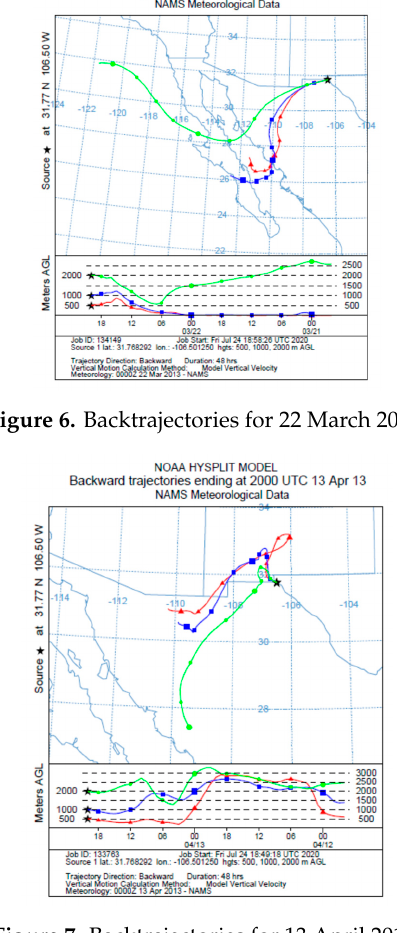
Figure 7. Backtrajectories for 13 April 2013.